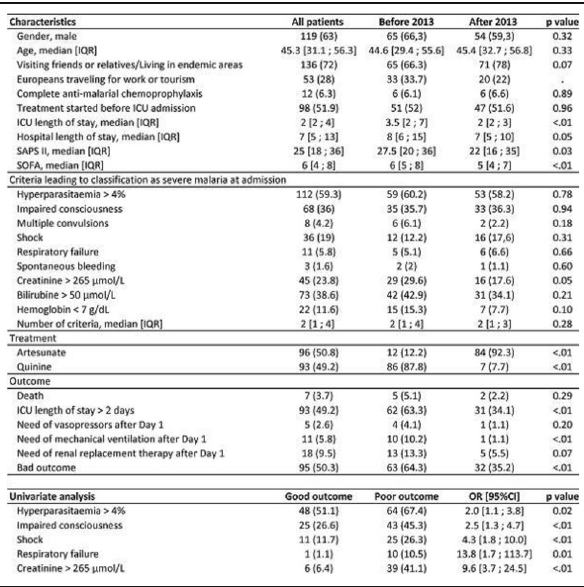
Table 1 (abstract 0168). Patients' demographics and outcome according to